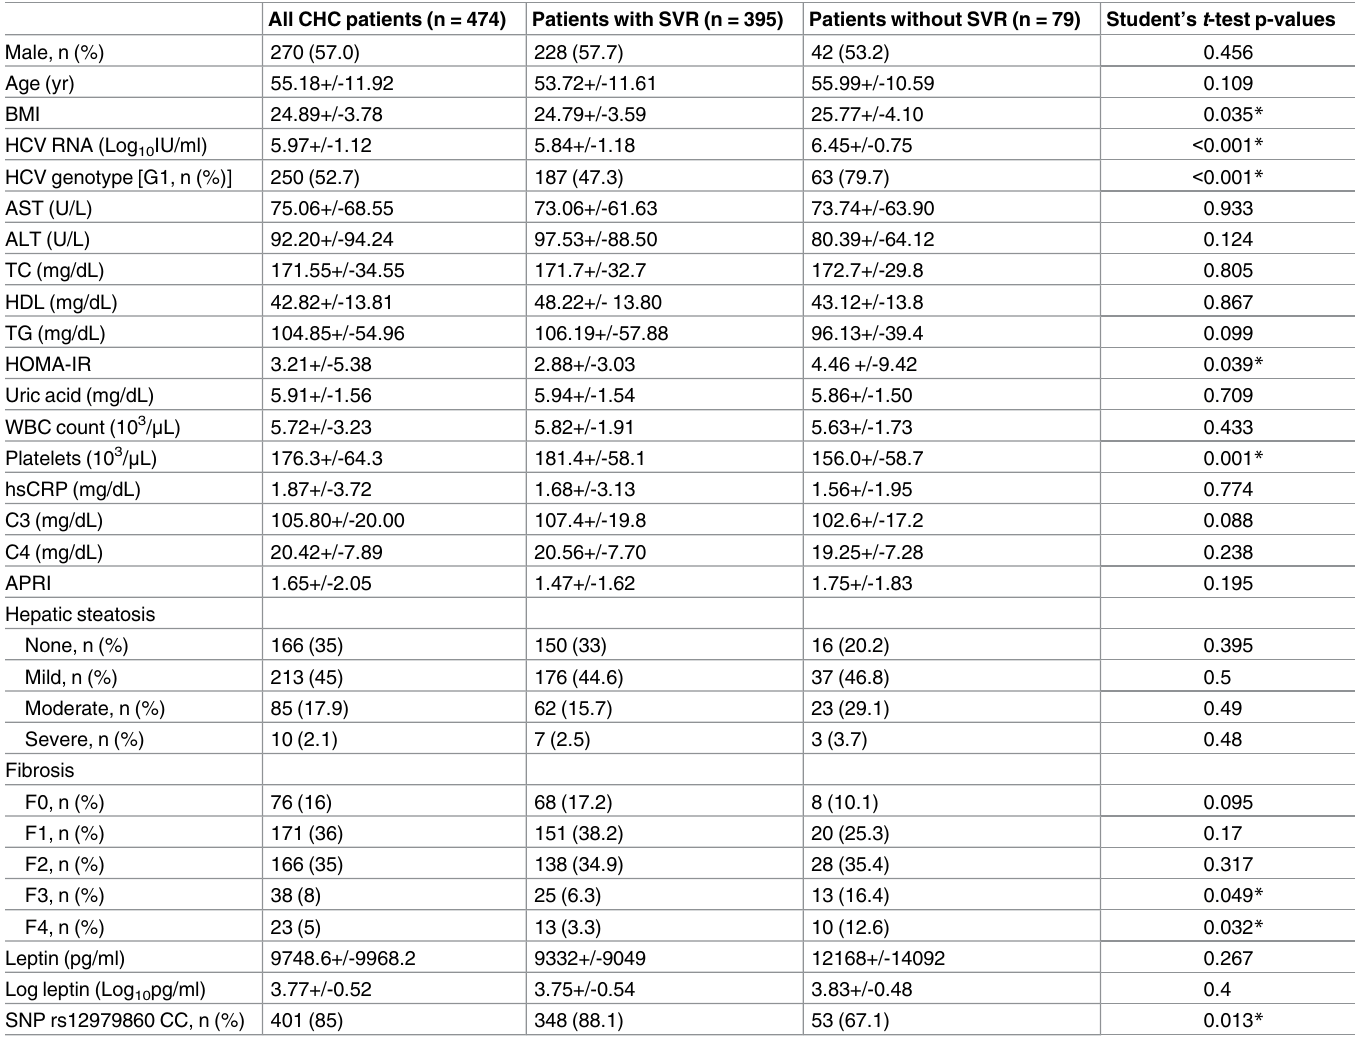
Table 1. Baseline characteristics of CHC